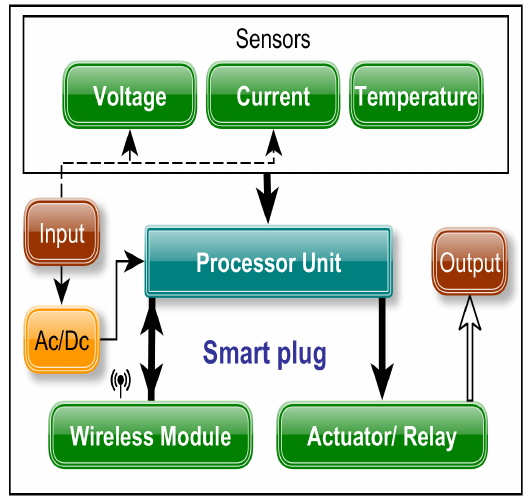
Figure 2. Simple structure of a smart